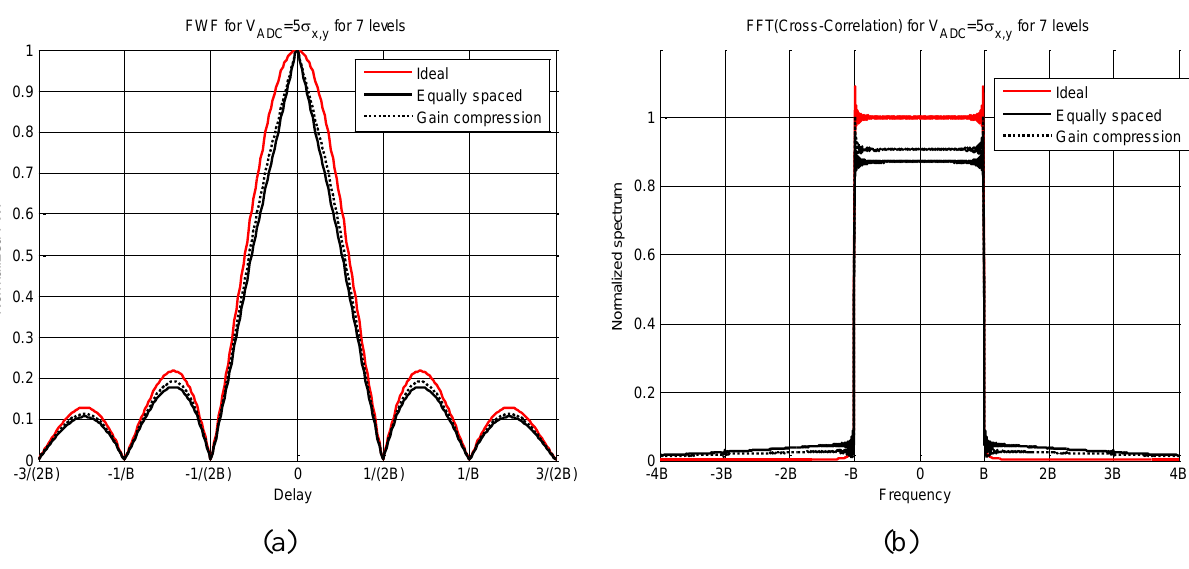
Figure 7. Effect of the quantization on the cross-correlation spectrum, (a) ideal cross-correlation ( ) and cross-correlation for two different quantization schemes using 7 levels, and (b) presents their corresponding